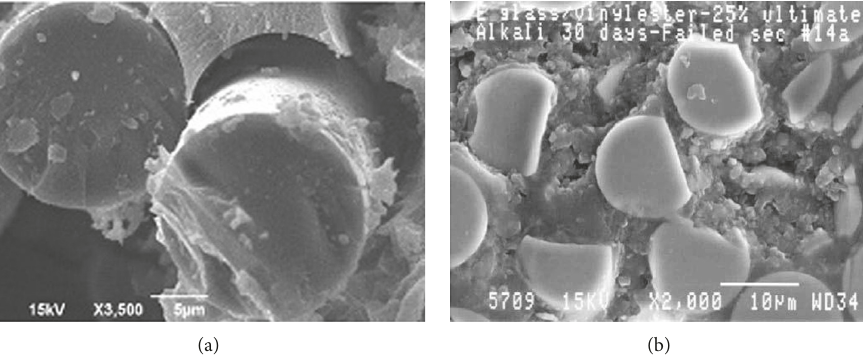
Figure 16: Micrograph of conditioned GFRP reinforcing bar. (a) Damage A (adapted from [10]). (b) Damage B (adapted from [28]).